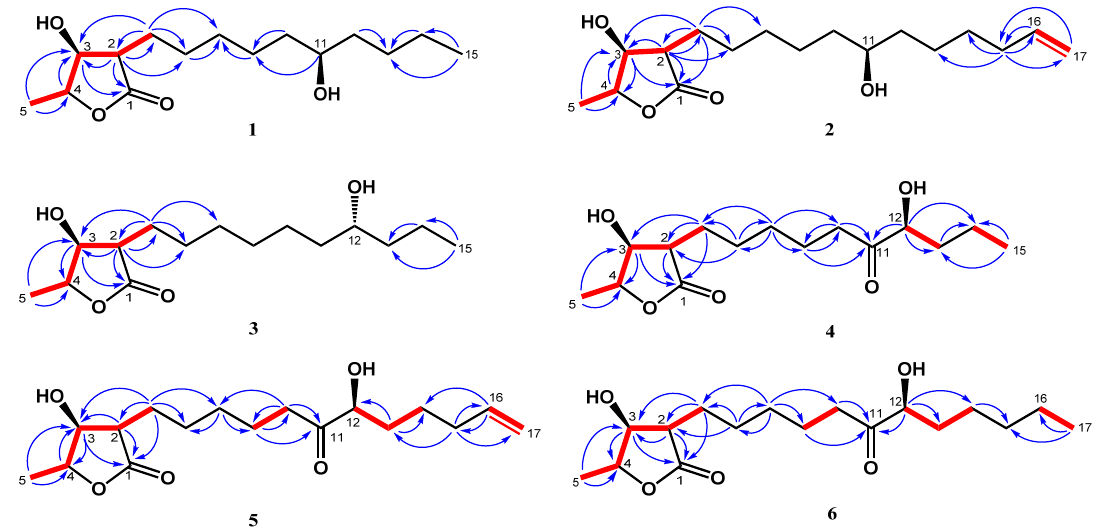
Figure 2. Key 1 H- 1 H COSY ( ━ ) and HMBC (H → C) correlations of machinolides A–F ( 1 – 6 ).